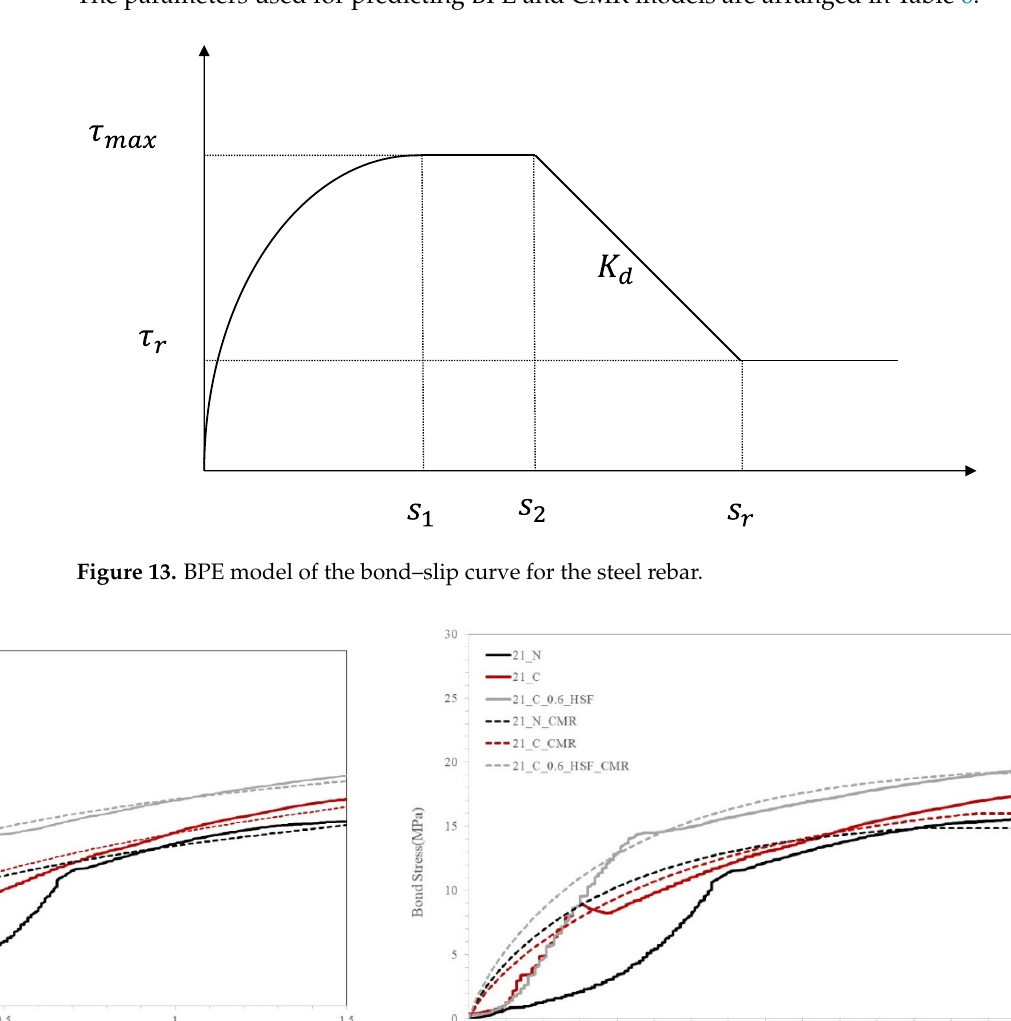
Table 7. Experimental results of the proposed model.